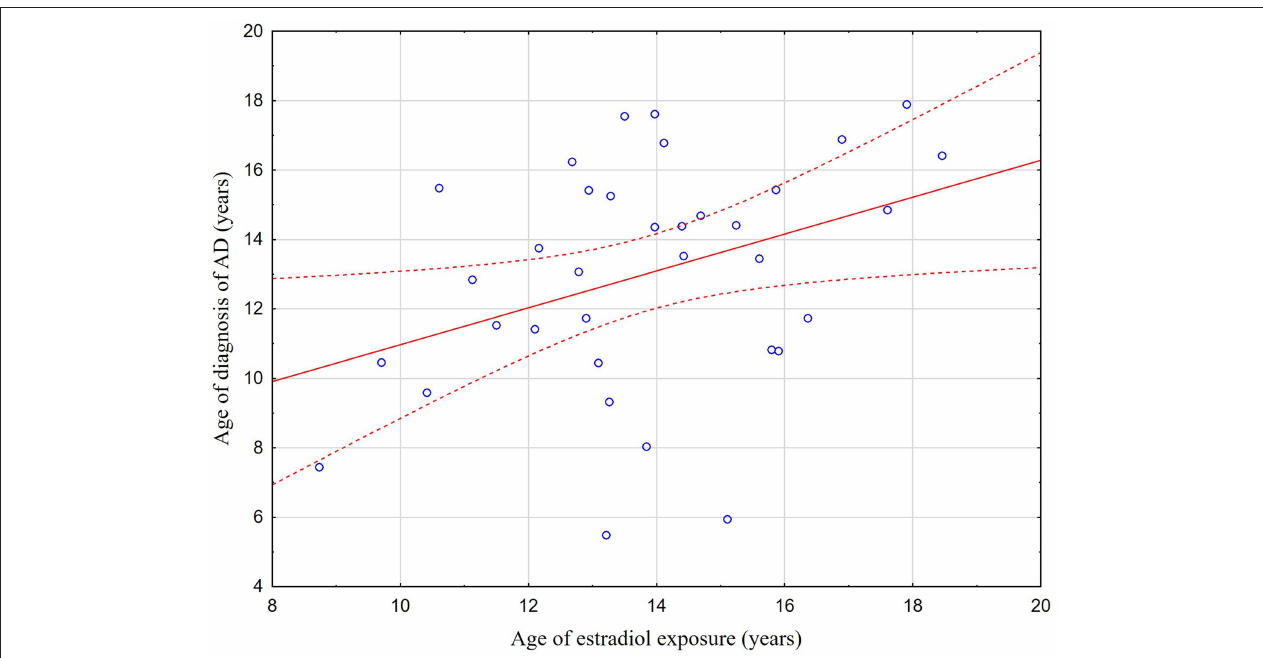
FIGURE 1 | Correlation between the age at estradiol exposure and the age at AD diagnosis. The scatterplot showing the weak positive correlation between the age at estradiol exposure and the age at AD (r = 0.37; p = 0.029). Statistical method: the Pearson’s correlation. Level of significance: P < 0.05.